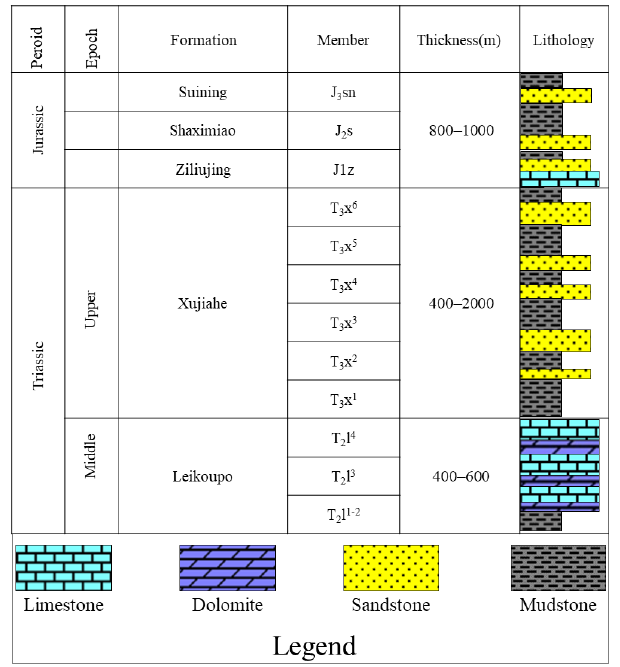
Figure 2. Stratigraphy of Triassic and Jurassic in the study area. The Triassic Xujiahe formation is the target formation.